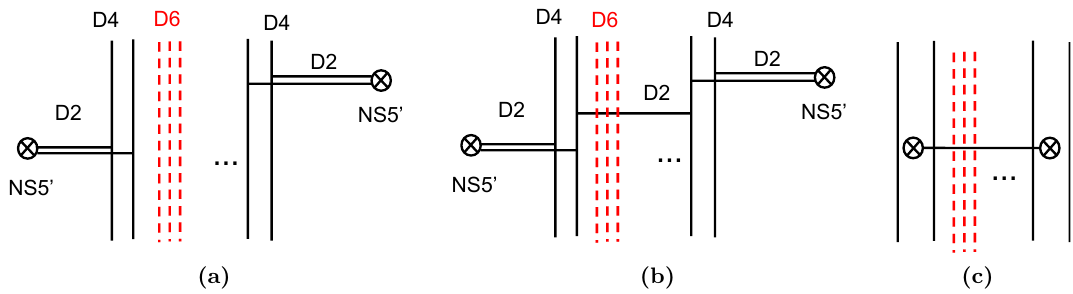
Figure 9. (a) The brane configuration for an ’t Hooft loop with B = e N + e N − 1 − e 1 − e 2 . (b) A D2-brane suspended between two D4-branes is introduced to describe ’t Hooft-Polyakov monopole which screen the magnetic charge. (c) After D2-brane moves with Hanany-Witten effects, we obtain a brane configuration for the SQM with v = e N − e 1